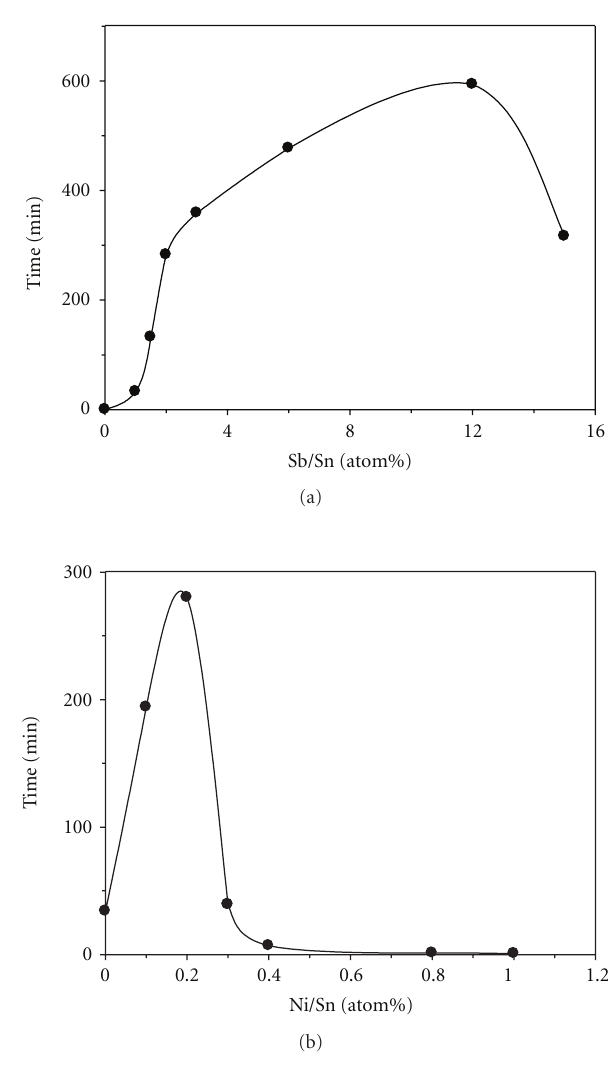
Figure 11: Dependence of service life times of (a) Ti / SnO 2 -Sb( x %)- Ni(0.2%) electrodes on Sb% and (b) Ti / SnO 2 -Sb(2%)-Ni( x %) electrodes on Ni%. The life times were obtained by the accelerated life tests under current density of 200 mAcm − 2 in 0.1M H 2 SO 4 solution. The values in parentheses are atomic ratios with respect to